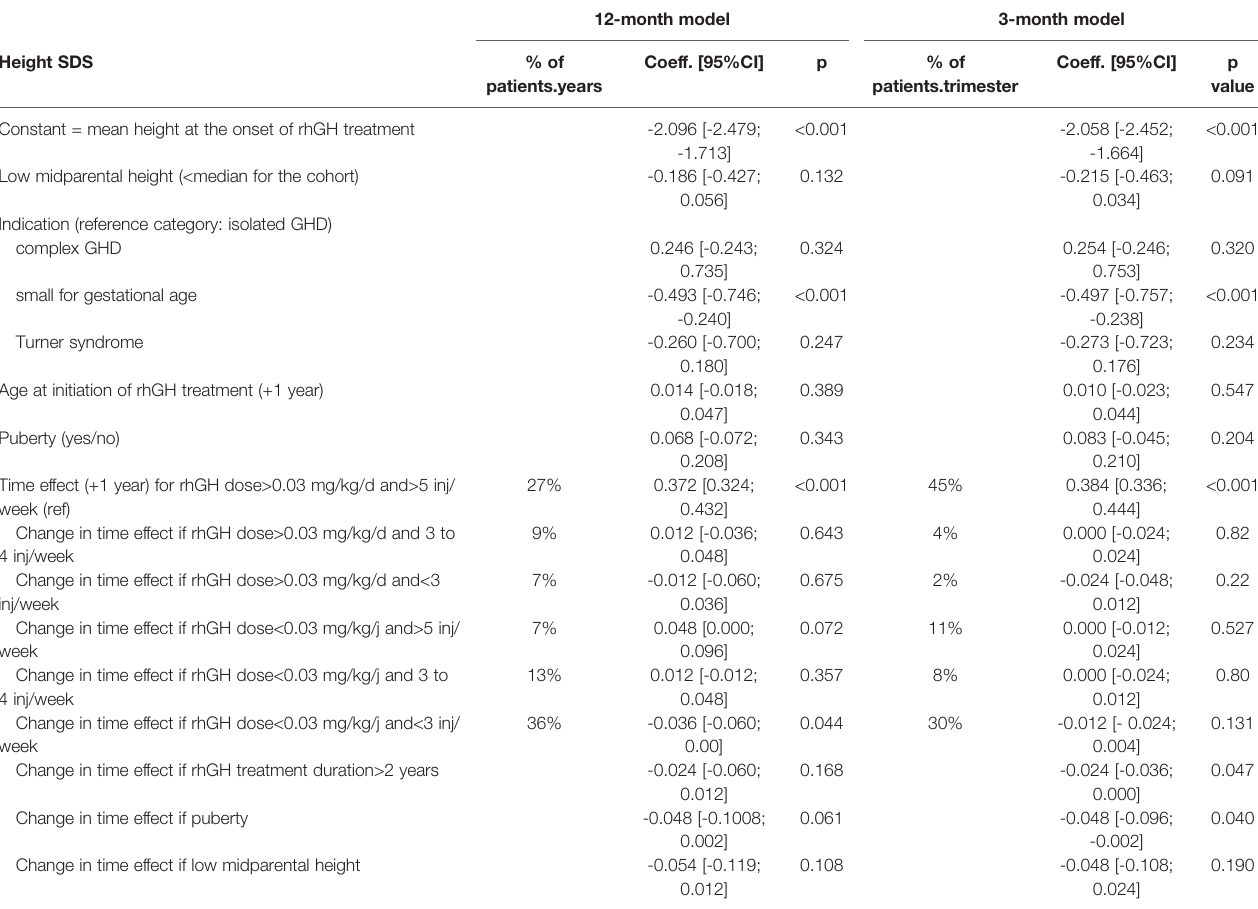
TABLE 2 | Linear mixed models for the change in height SDS over 12 months with a time unit of 12 months or 3 months when computing the true mean daily rhGH dose and mean number of injections per week (corresponding to a total of 685.2 patient years, or 2741 patient